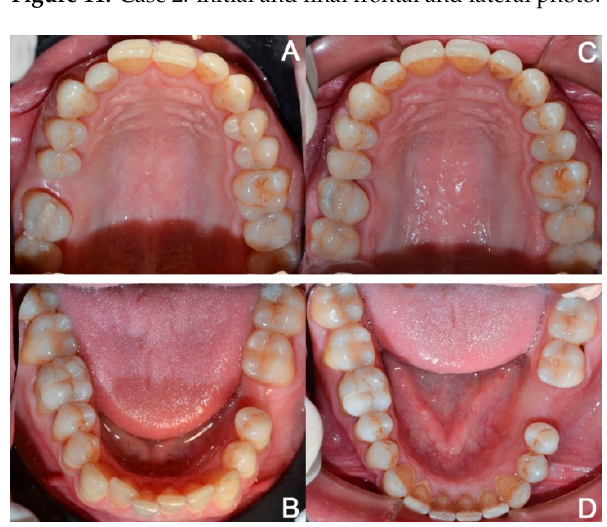
Figure 11. Case 2: initial and final frontal and lateral photo.